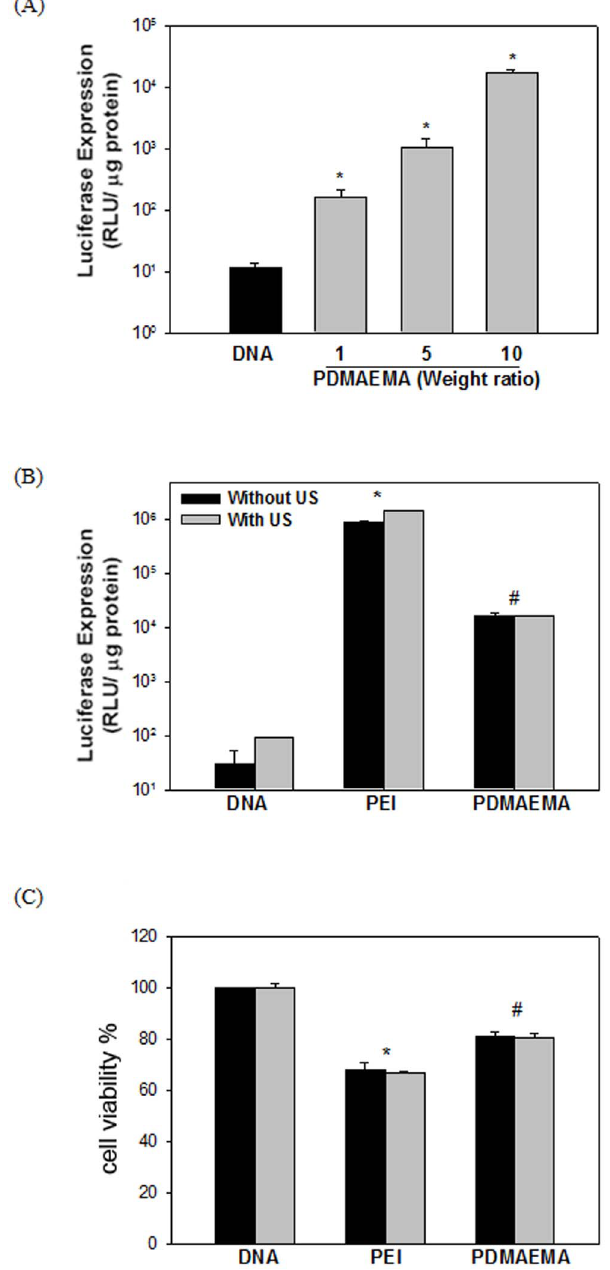
Figure 3. Transgene expression following invitro PEI/DNA and PDMAEMA/DNA with US exposure. (A) One m g DNA was gently mixed with PDMAEMA with different weight ratios (1, 5, 10) or PEI (N/P ratio: 5) at room temperature and incubated for 10 min to form nanoparticle complexes, (B) which were then added to cultured cells and transfected by sonoporation. Luciferase expression was evaluated and compared. (C) Cell viability was assessed by MTT assay 24 h following US treatment and compared with no US condition. All results are expressed as the mean 6 SEM for six independent experiments. # P , 0.05 vs. PEI or PEI with US; *P , 0.05 vs. DNA or DNA with US.